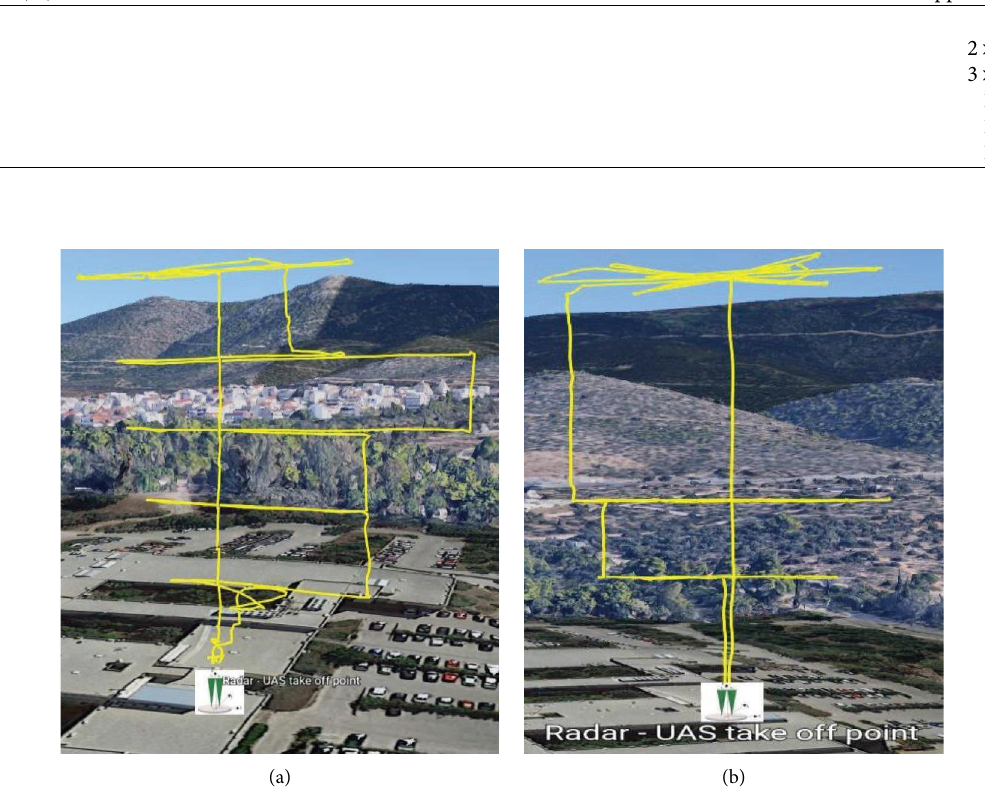
Figure 6: Flight paths for the static radar mode, with UAS fights in (a) straight lines and (b) “ X ”-shaped